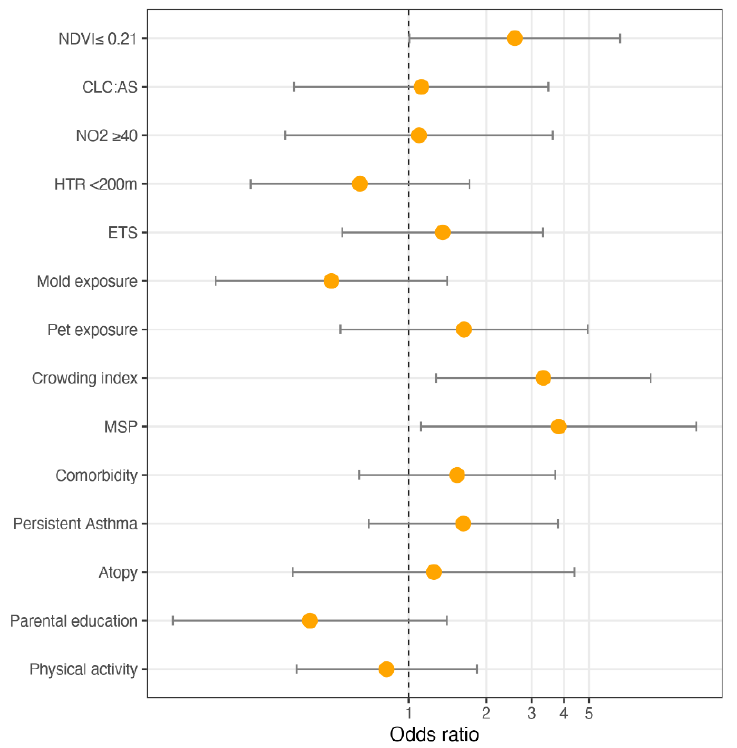
Figure 5. ORs and 95% CI of the mixed-effect logistic regression model for asthma control: sensitivity analysis adjusting for physical activity (>3 times per week).